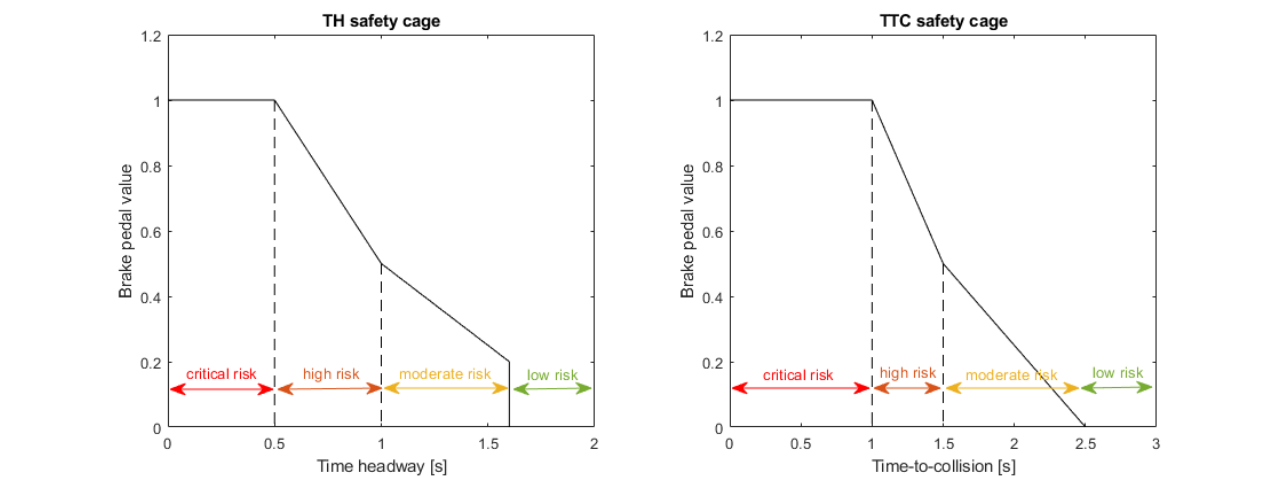
Figure 2. Risk-levels and minimum braking values for each safety